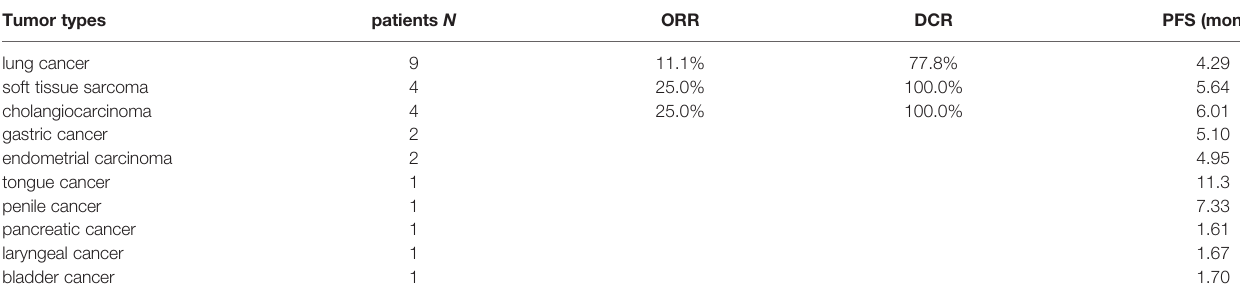
ECOG, Eastern Cooperative Oncology